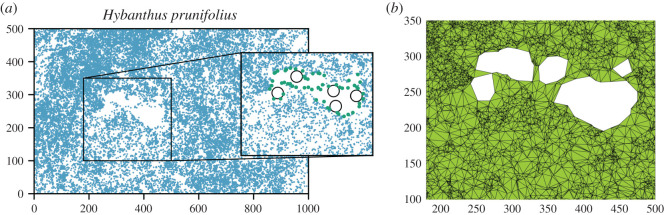
Example of non-trivial borders in the case of H. prunifolius. (a) The distribution of H. prunifolius individuals (points) in the 8th BCI census clearly displays a big empty region. The inset shows how using α-shapes (a few circles with radius α = 14 are shown) one can identify the internal border (green points represent the border trees). (b) Once the border trees are identified, Delaunay triangulation allows to measure the covered area, and thus estimate the average tree density, ρα, with the empty region excluded.